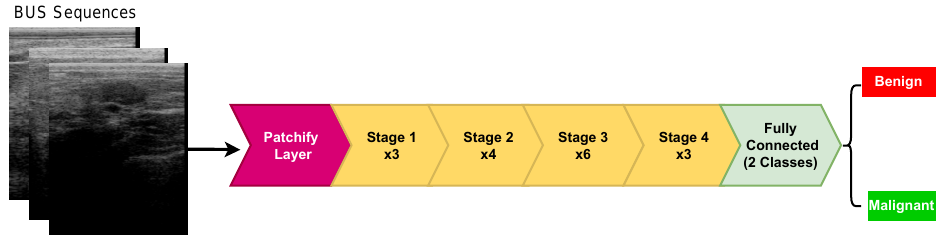
Figure 3. Schematic diagram of ConvNeXt. It should be noted that × 3, × 4, × 6, and × 3 mean that there are 3, 4, 6, and 3 blocks in stage 1, 2, 3, and 4, respectively.